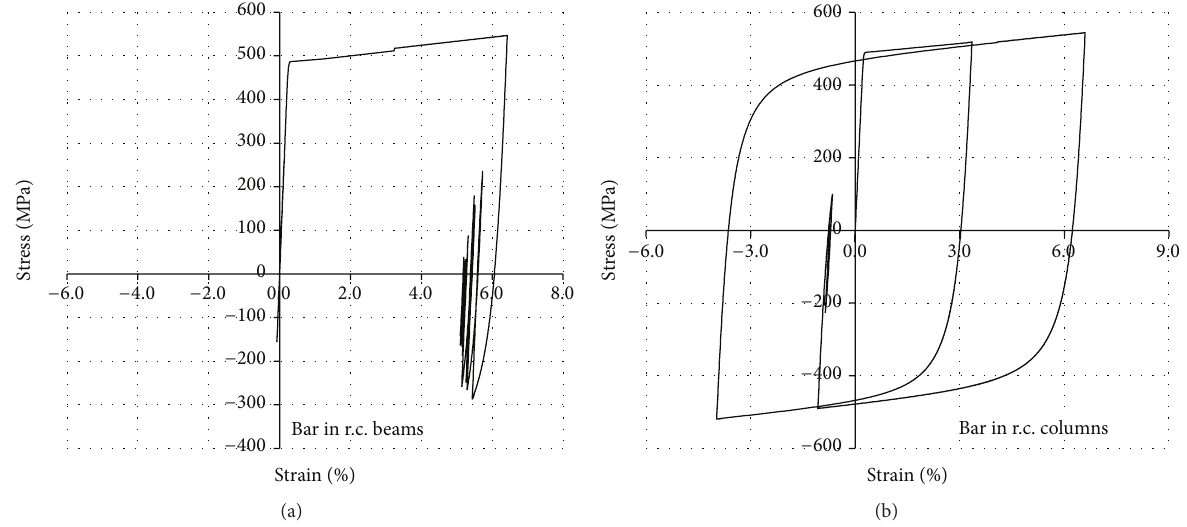
Figure 3: (a) Numerical stress-strain diagrams for bars in r.c. beams, (b) numerical stress-strain diagrams for bars in r.c.